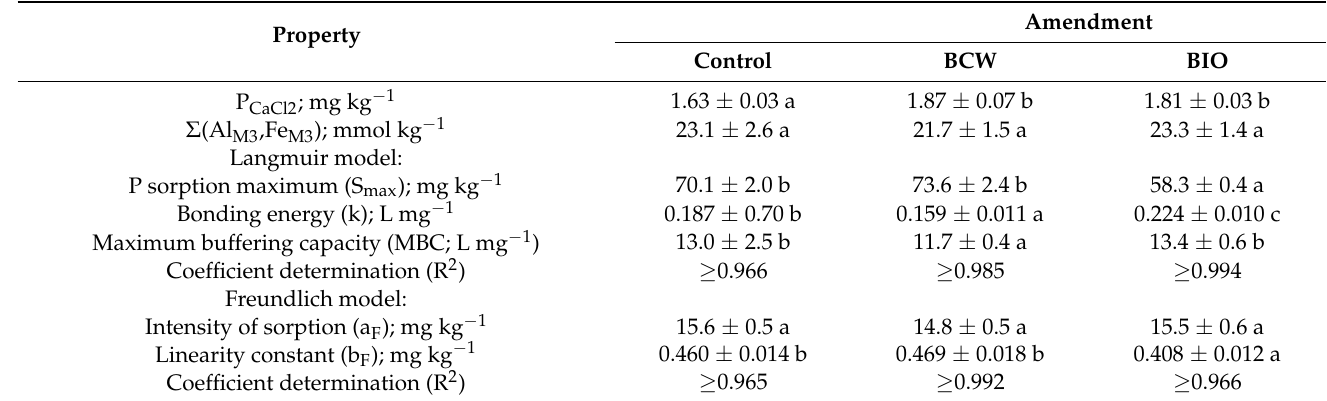
Table 4. Phosphorus sorption parameters of soil amended with brown coal waste (BCW) and conifer woodchip biochar (BIO) from the field experiment compared to the control (mean ± standard deviation, n =